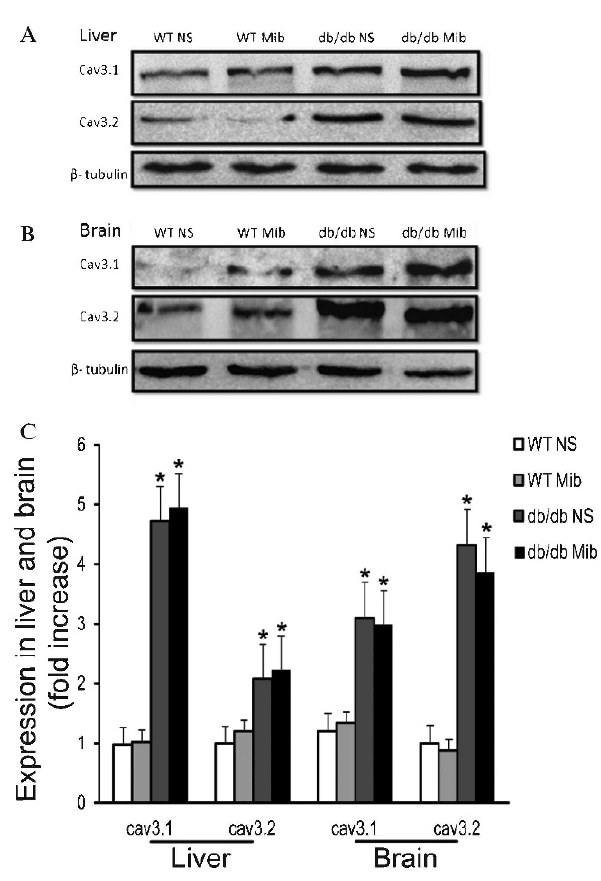
Figure 4 - Western blot analysis of T-type Ca 2 + channel expression in liver and brain tissues of diabetic and nondiabetic mice. Increased expression of a 1G (Cav3.1) and a 1H (Cav3.2) subunits of T-type Ca 2 + channels (n=3). The molecular weights of Cav3.1 and Cav3.2 are , 262 kDa. * p , 0.05, n=6, compared with WT NS group. Statistical analyses were performed with ANOVA.